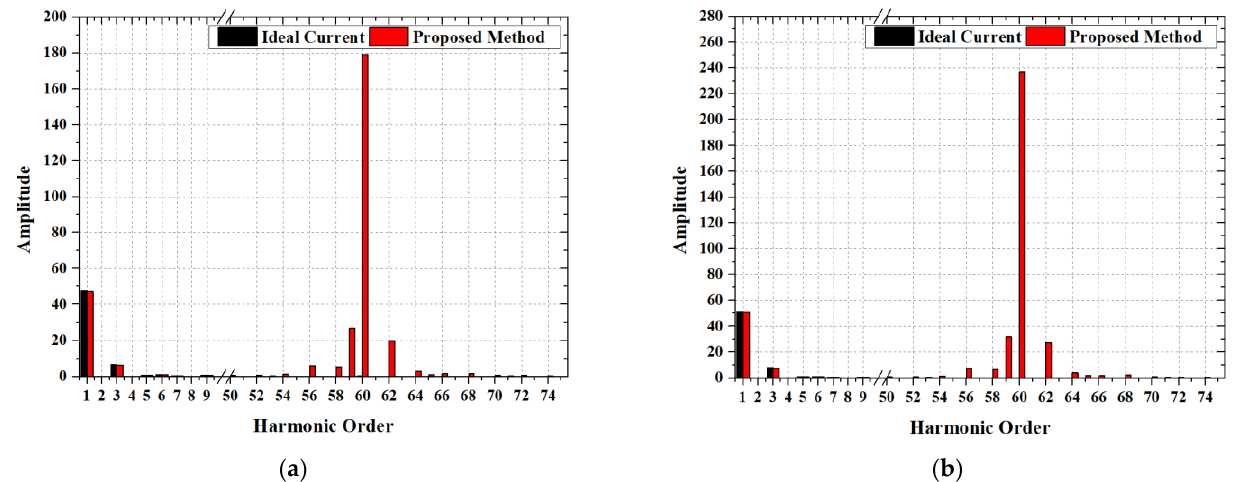
8 of 11 Table 5. Case 2: 155 Nm at 1000 rpm. Method